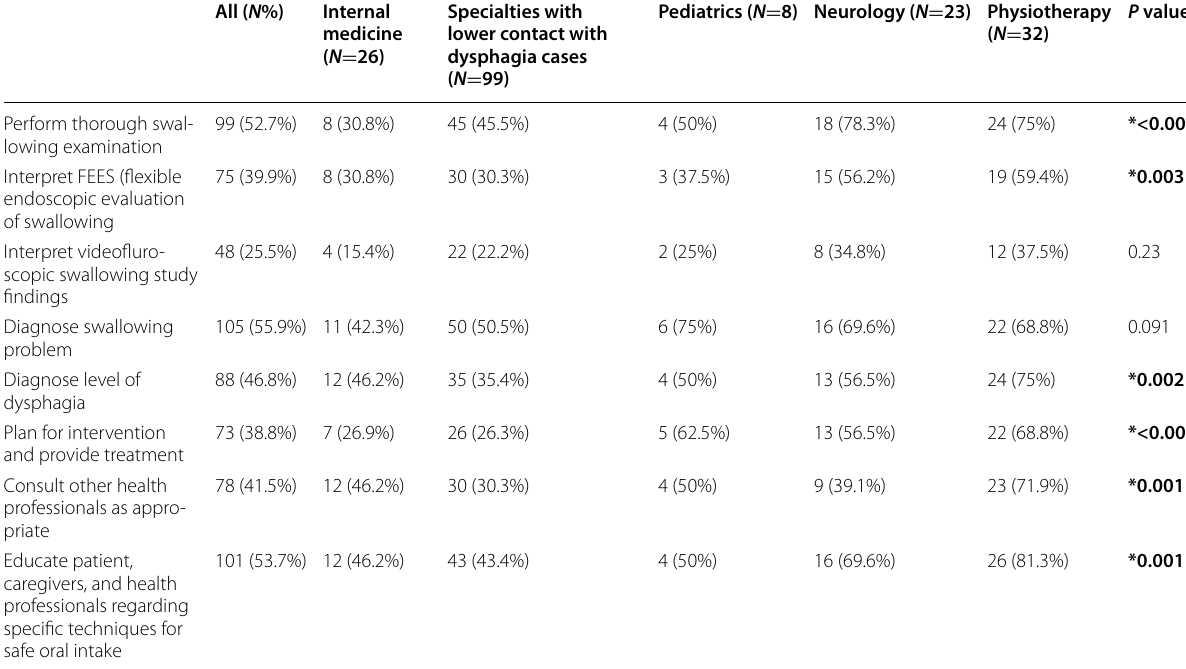
Table 8 Percentages and comparison among the participants in different specialties regarding their responses about the role of phoniatricians in swallowing management